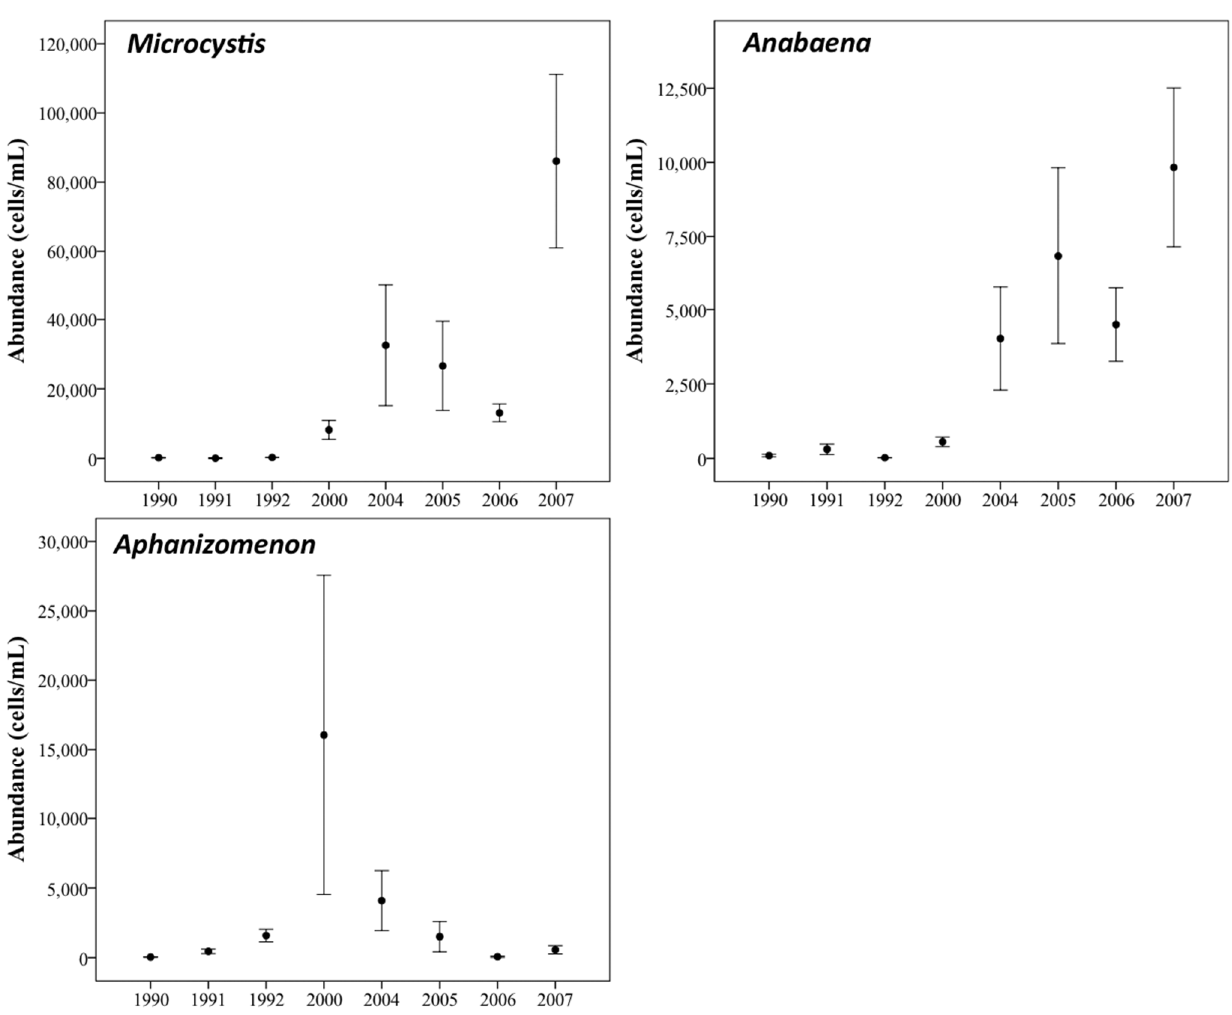
Figure 9. Summer mean abundance of Microcystis (upper left panel), Anabaena (upper right panel) and Aphanizomenon (lower left panel) in the inner bay of Green Bay. Error bars indicate ±1 SEM. Note change in scales between